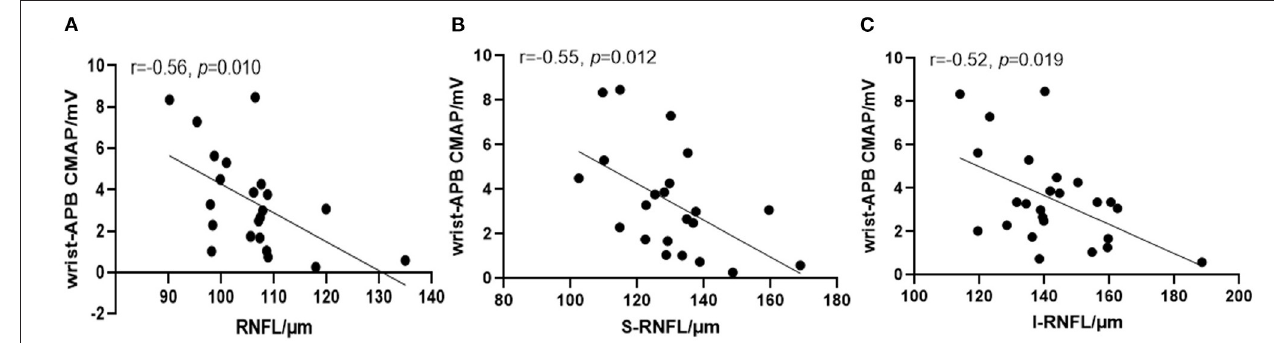
FIGURE 3 | Partial correlation analysis between RNFL and the CMAP amplitude recorded from the abductor pollicis brevis after median nerve stimulation. The global (A) , superior (B) and inferior (C) quadrants of the RNFL thickened significantly as the abductor pollicis brevis (APB)-CMAP amplitude declined.